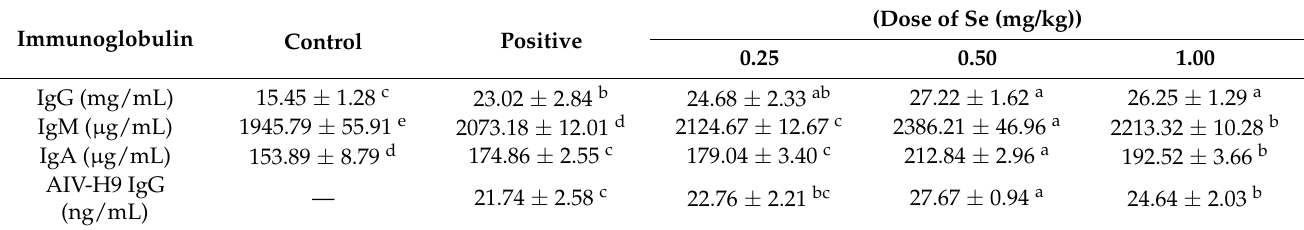
Table 2. The effect of Glycine nano-selenium on immunoglobulin content. (Dose of Se (mg/kg)) Immunoglobulin Control Positive 0.25 0.50